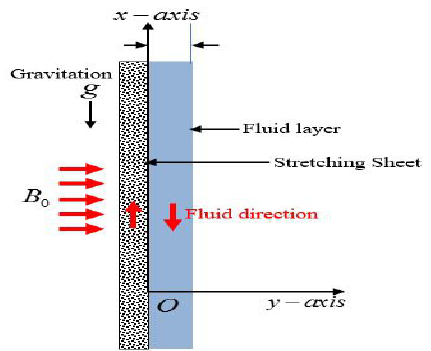
Figure 1. Geometry of the physical flow